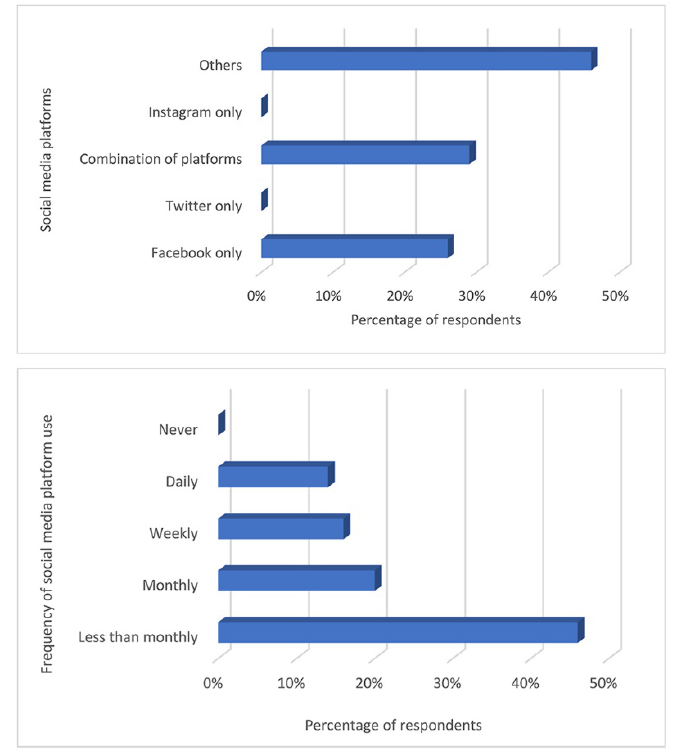
Figure 2 Social media accounts used to communicate with Nigerian medical library users (top) and frequency of social media use